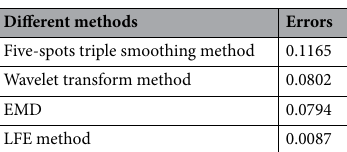
Table 1. Comparisons of the RMS values of